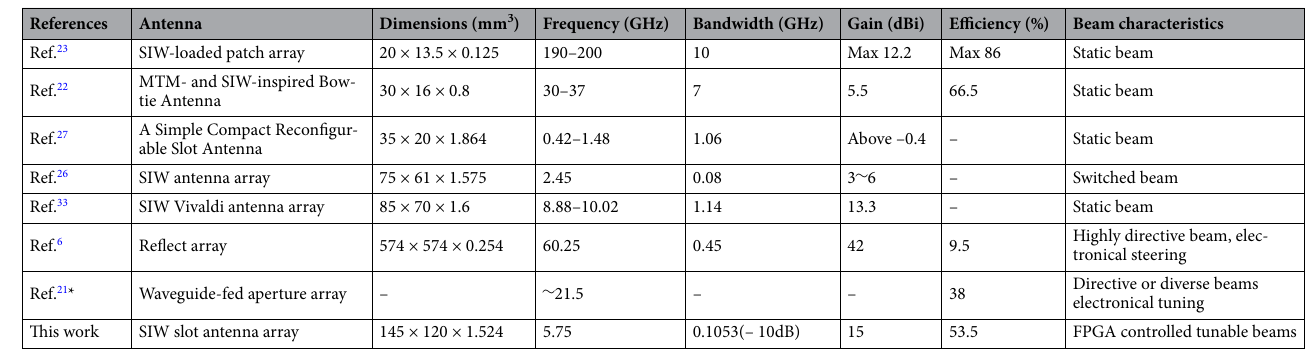
Table 1. Comparison of some indexes among several references with this work. *Denotes that only the simulation results are included in the reference. –Denotes that this index is missing in the